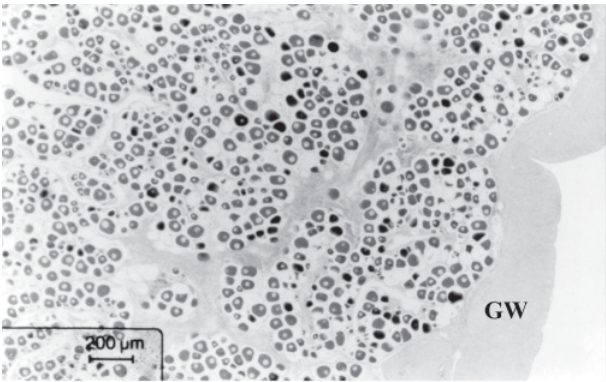
Fig. 8. Transverse section of a resting ovary of Mycteroperca bonaci . Gonadal wall (GW). Stain: H. E.